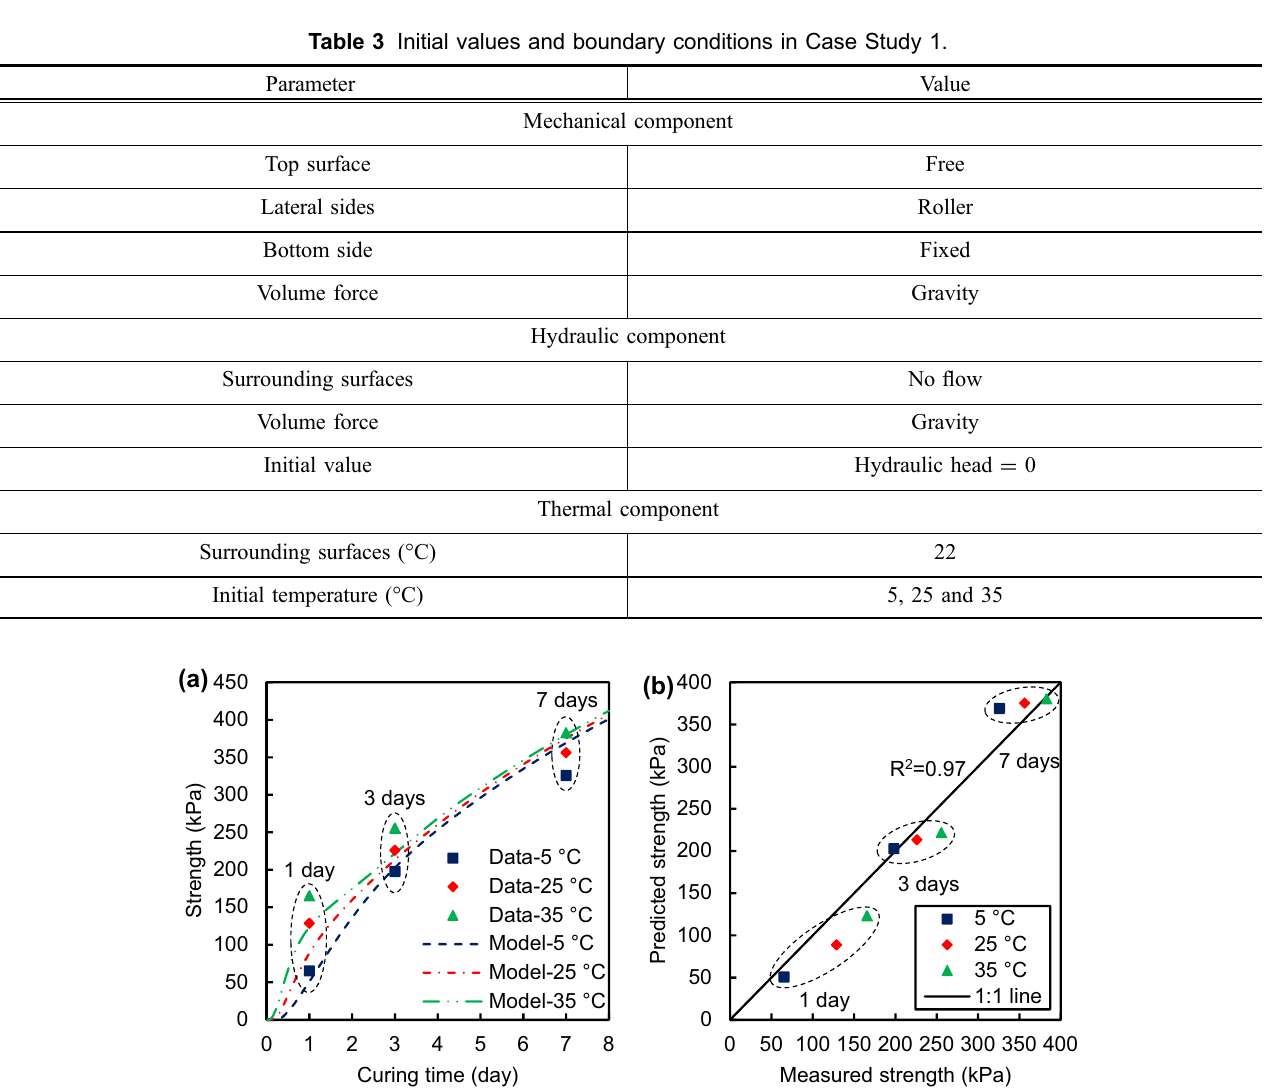
Fig. 8 Comparison of predicted results and experimental values of true CPB strength: a changes to CPB strength with curing time and b correlation between simulated results and measured values.